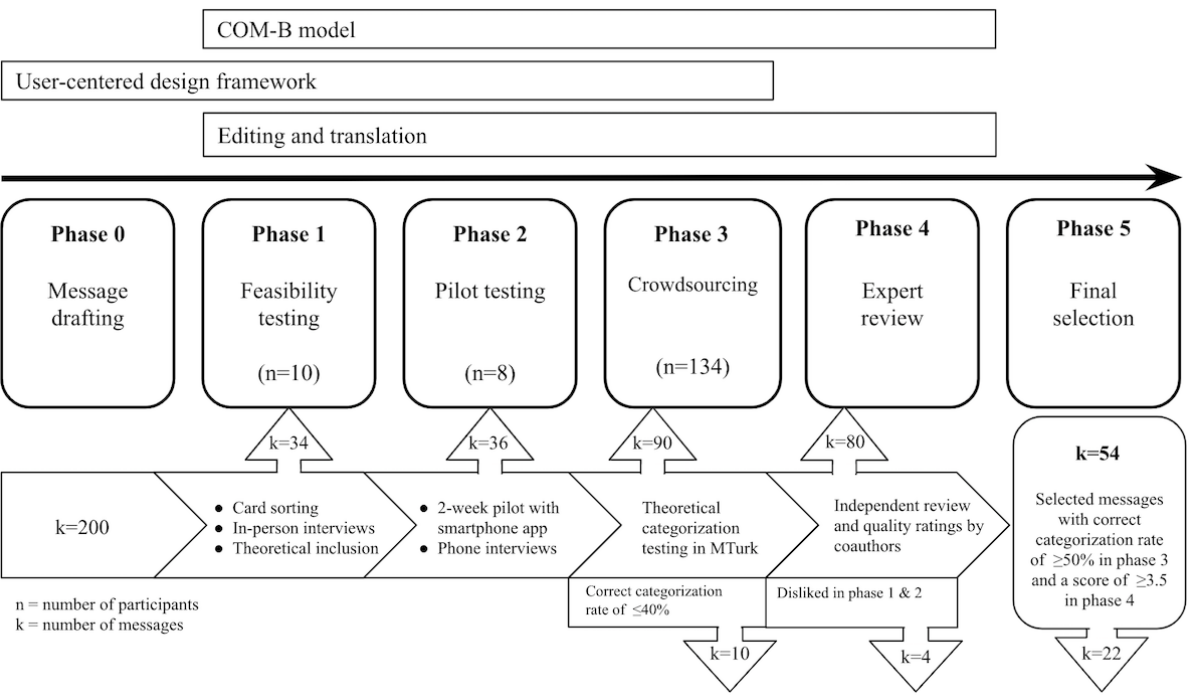
Figure 1. Theory-based, user-centered design framework: phases and methods of the message development process. COM-B: capability, opportunity, motivation, and behavior; MTurk: Amazon Mechanical